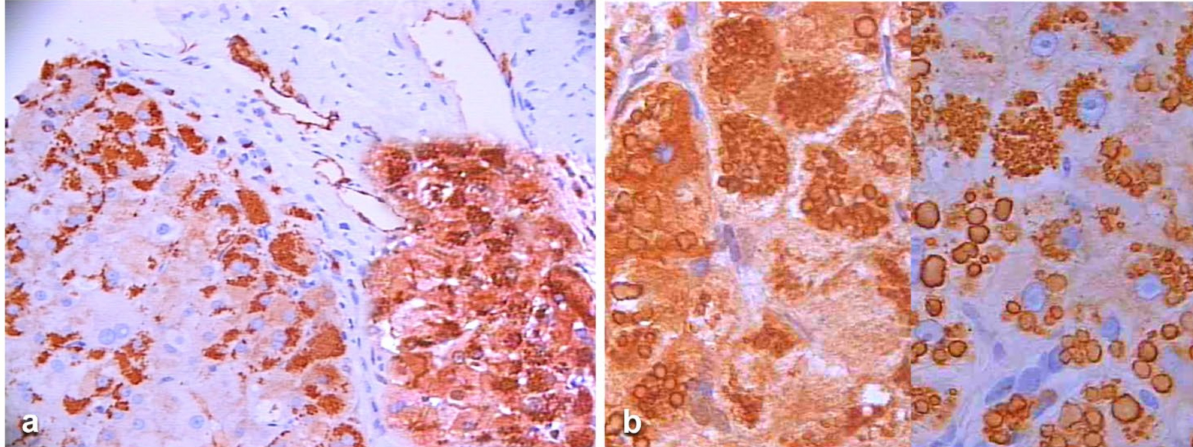
Figure 7. The polyclonal stained section (box) has overridden the portal tract of the monoclonal one where endothelial cells are positive to the AZT 11 antibody. ( a ) Photo collage of two consecutive immunostained sections subtracting the monoclonal from the polyclonal stain ( b ).